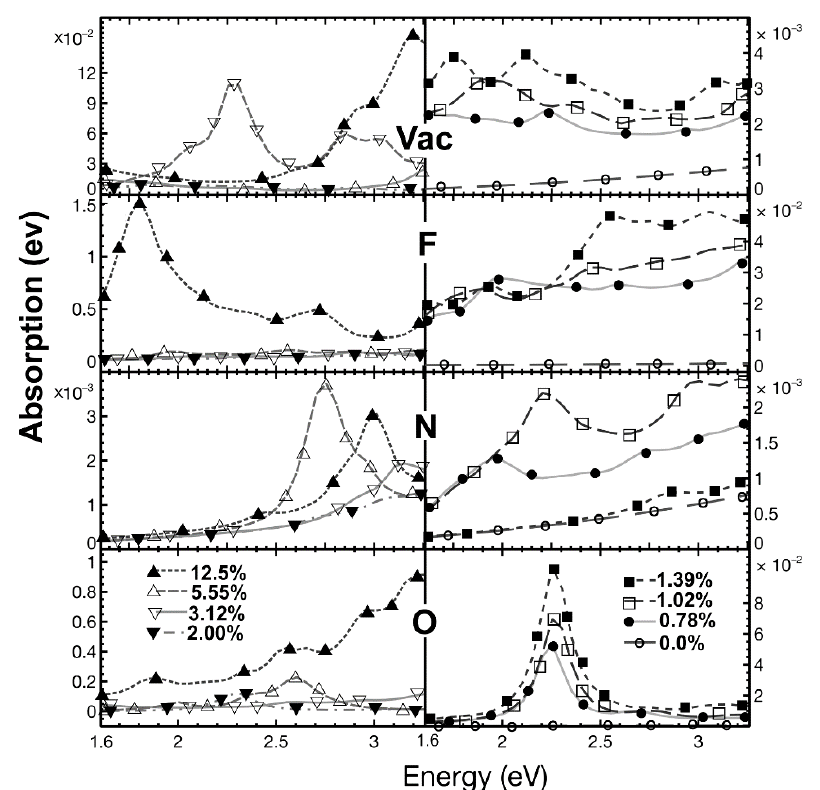
Figure 16. We present the absorption in the visible region for different dopant (or vacancy) concen- trations. For 0% (pristine graphene): ; for 0.78%: ; for 1.02% □ ; for 1.39%: ◼ ; For 2.0%: ; for 3.12%: ; for 5.55%: ; for 12.5%: ▲ . At the top, we have the absorption for different vacancy con- centrations. At the bottom, we have the optical absorption for different oxygen percentages. As in the two previous cases, we show the absorption for fluorine and nitrogen for the same concentration variation in the middle. The horizontal axis marks the energy of incident electromagnetic radiation.